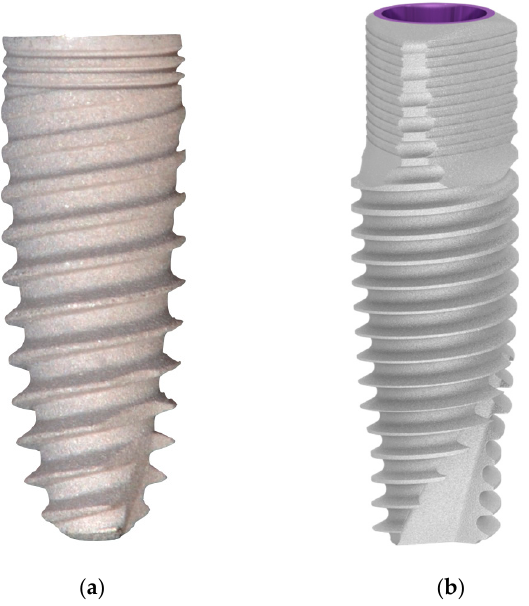
Figure 1. Implant designs compared in the study: C1 ® implant ( a ) and V3 ® implant ( b ).